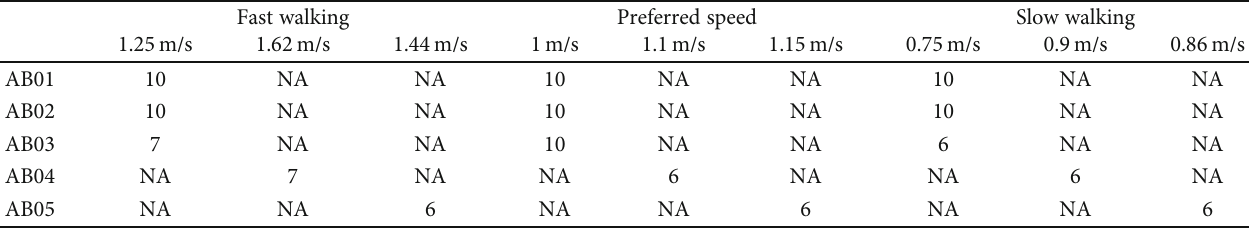
Table 5: The number of trials (repetitions) is listed for each walking speed for the participants with intact limbs. Note that the preferred walking speed varies with each subject.